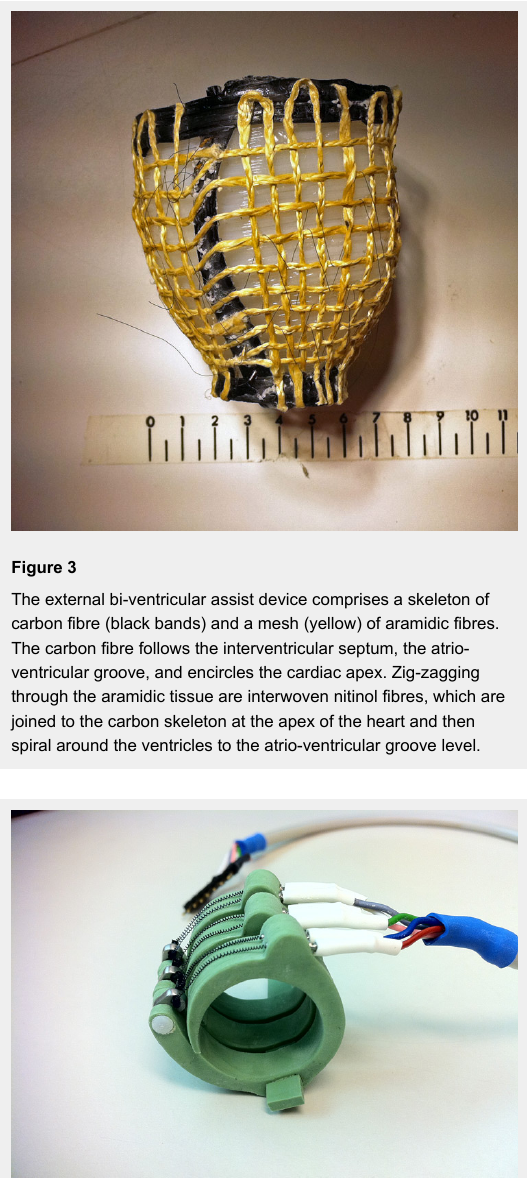
The urinary sphincter is made of 3 silicon rings (green part) whose diameter decreases when the nitinol fibre (black springs) is activated. The rings are placed around the urethra. Up to 5 rings could be placed to ensure the optimal control of urinary flow reducing the risk of urethra lesions.